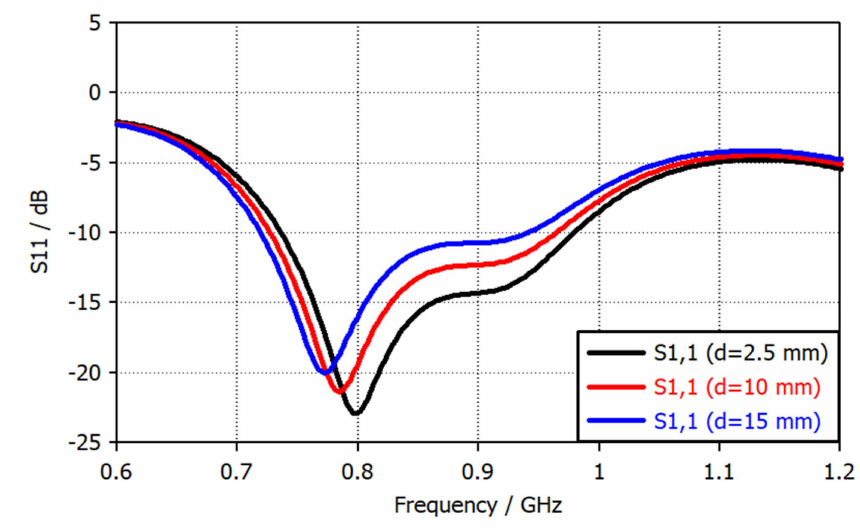
Figure 5. S11-parameter versus frequency for different values of d in